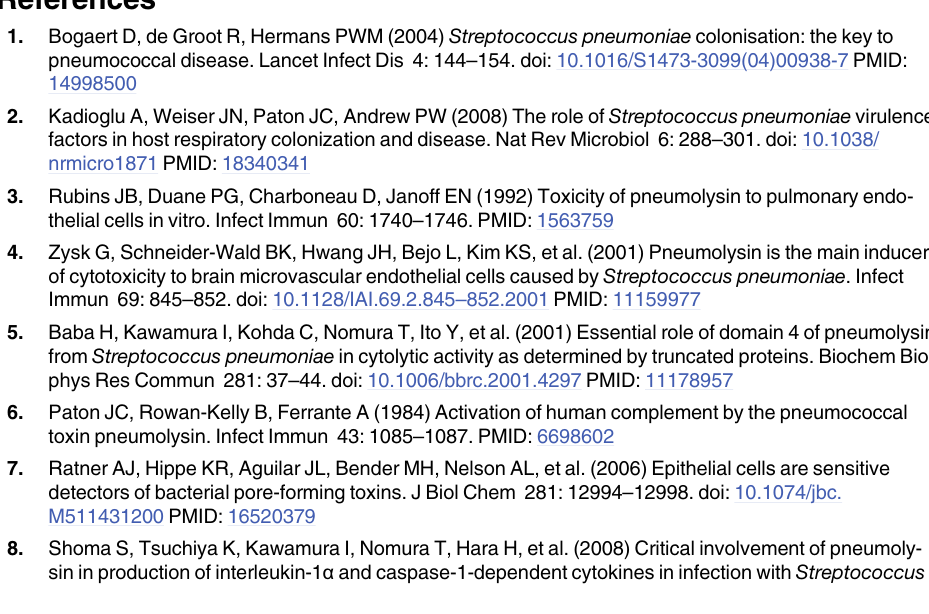
S3 Fig. Quantification of murMN expression in the malM-murMN strain grown with and without inducer. Relative expression of murM and murN compared to wt (set to 1) in malM- murMN grown in the absence (THY) or presence (THY + 0.8% maltose) of inducer. Transcript abundance was normalized to the housekeeping gene, rplI . (TIFF) S4 Fig. Peptide structures of the indicated peaks in Figs 2D and 4C. (TIFF) S5 Fig. Sensitivity of the β -galactosidase assay used to measure LacZ release. Three indepen- = 0.8, pelleted by centrifuga- dent cultures of Δ bga :: spec-lacZ (AC5073) were grown to OD 600 tion, resuspended in hemolysis assay buffer, and sonicated to generate whole cell lysates as described in Materials and Methods . Each lysate was serially five-fold diluted three times to make a dilution series (1x, 0.2x, 0.04x, 0.008x). (A) β -galactosidase activity of each dilution was detected using Miller assays. (B) Miller units of each dilution plotted as a function of the per- cent starting material yields a linear relationship down to 0.89%. Each symbol represents three overlapping symbols that each depicts a biological replicate. The coefficient of determination (R 2 ) was determined using GraphPad Prism 6 software.